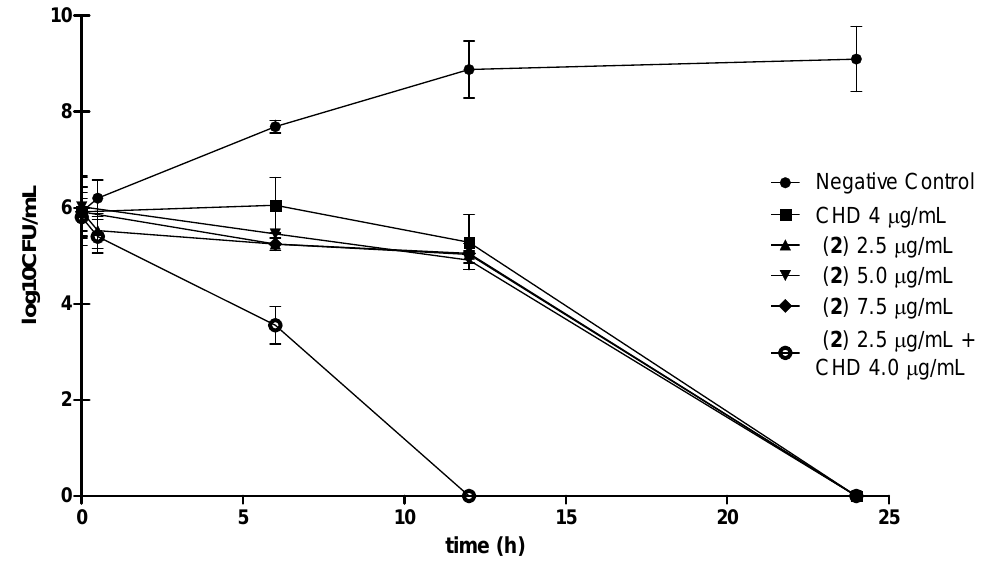
Figure 3. Time-kill curves for 2 in different concentrations and its association with CHD in their MBC values. Positive control: